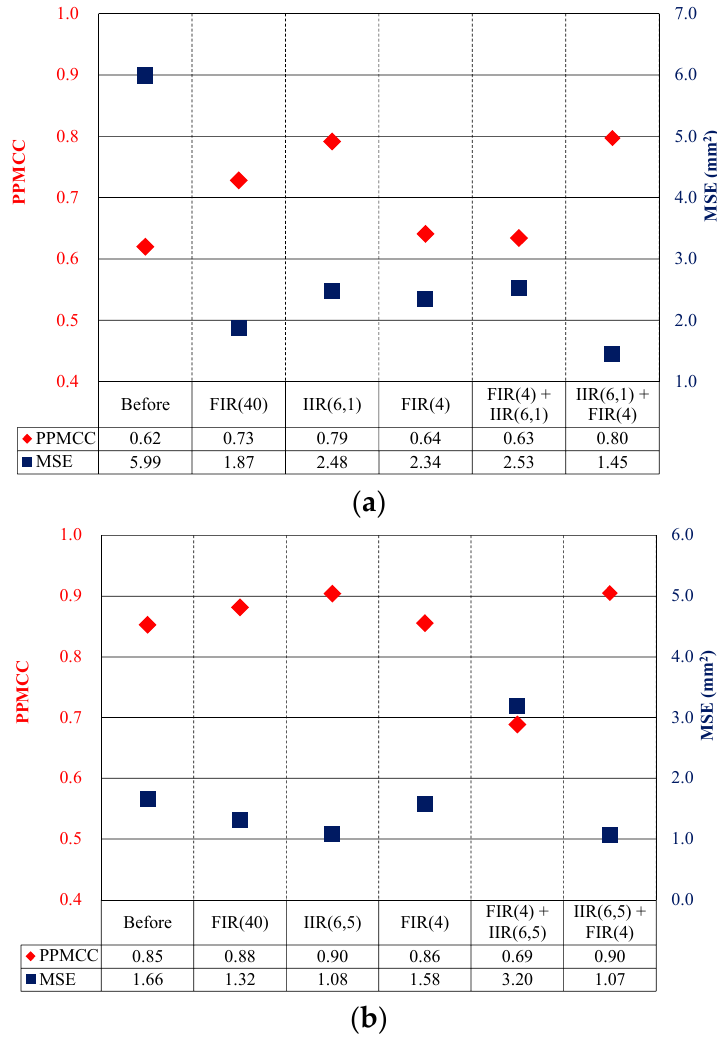
Figure 6. Comparison of PPMCC ( ♦ ) and MSE ( ■ ) of different models: ( a ) lateral direction; ( b ) vertical direction.